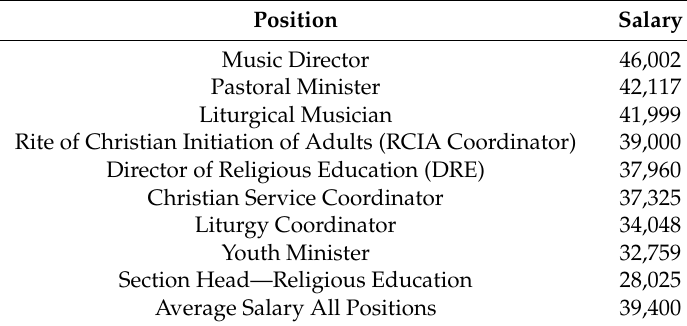
Table 2. Annual Salary of Full-Time Parish Ministers: